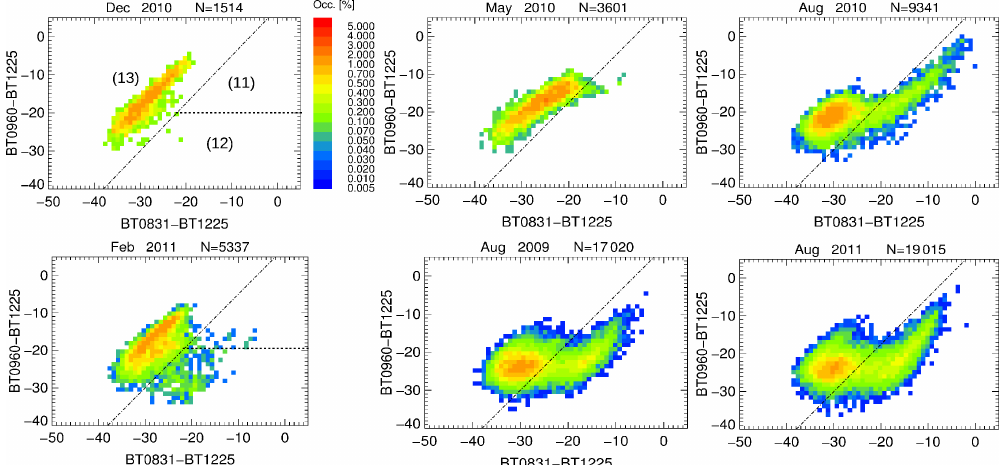
Figure 8. Monthly PDFs of BTD 831 − 1225 vs. BTD 960 − 1225 are presented for NH and SH conditions north and south of 55 ◦ N/S, respectively. NH December 2010, February 2011 (left column, corresponding to Figs. 3 and 5), SH May 2010, August 2010, as well as August 2009, and 2011 (middle and right column) for all cloudy observations (CI < 5) in the altitude range 16–30km. Areas for PSC classification regions (11), (12), and (13) are highlighted by dashed lines in the first figure (top left), where (11) is dominated by ice, (12) by large ice and small NAT ( l ICE_ s NAT; see also Table 2), and (13) by STS and large NAT particles (STS_ l NAT).